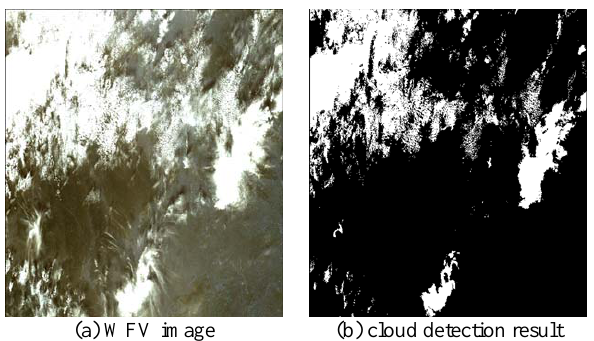
Figure 4. An WFV SC image and the result of the Gaussian mixture model based cloud